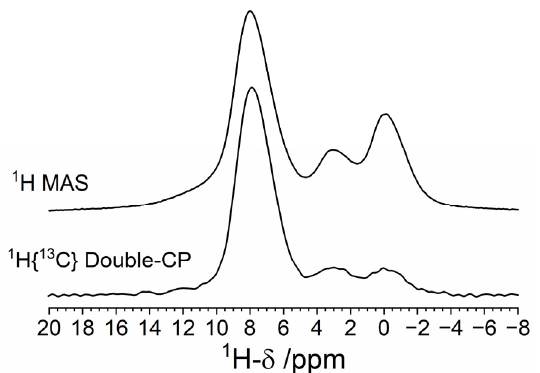
Figure 5. 1 H MAS (top) and 1 H{ 13 C} Double-CP (bottom) spectra for the [(Eu 5 Zr 3 )(btc) 9 (H 2 O) 18 ] compound. Both spectra were obtained under a 60 kHz MAS spinning rate.